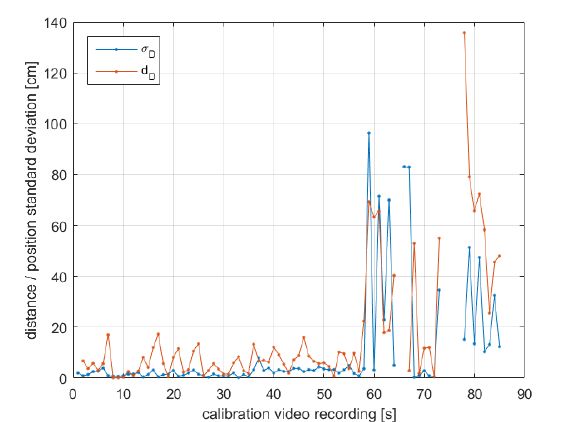
Figure 9: Variations d D of the estimated vehicle interior driver camera positions over the time of video recording, as well as the position standard deviation of the vehicle interior camera σ D . Plotted over the time the vehicle is standing still during the cali- bration drive. Line between discrete poses drawn for better visu-